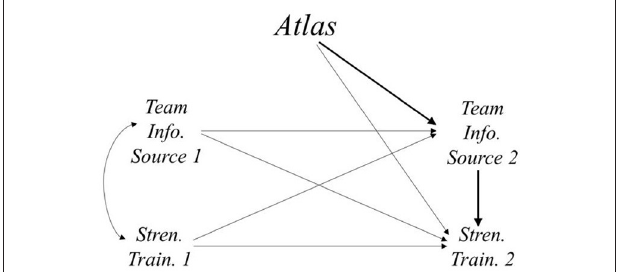
FIGURE 2 | Diagram of the model described in the empirical example. The bold path from Atlas to Stren. Train. 2 through Team Info. Source 2 indicates the mediated effect of the ATLAS program on strength training self-efficacy at posttest through its effect on team as an information source at